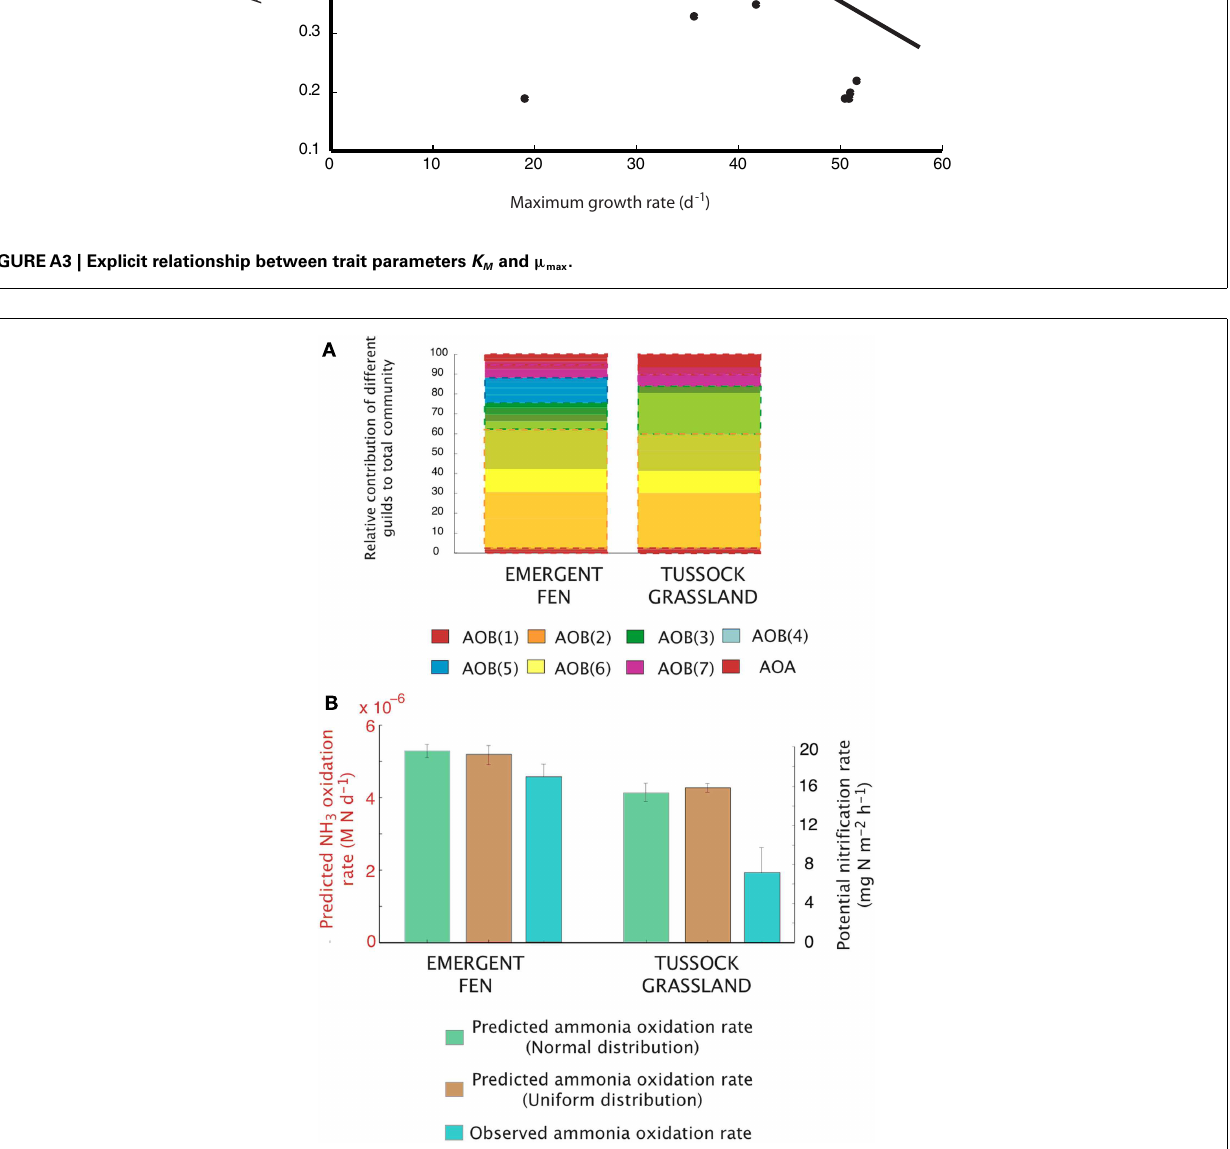
demarcate the different analogs/guild. A box outlines the boundaries of each guild’s biomass. Evenness statistic given above the bar plots. (B) Experimental observations reproduced from Petersen et al. (2012), showing the trends in potential nitrification rates under a normal distribution, a uniform distribution, and the observed NH 3 oxidation